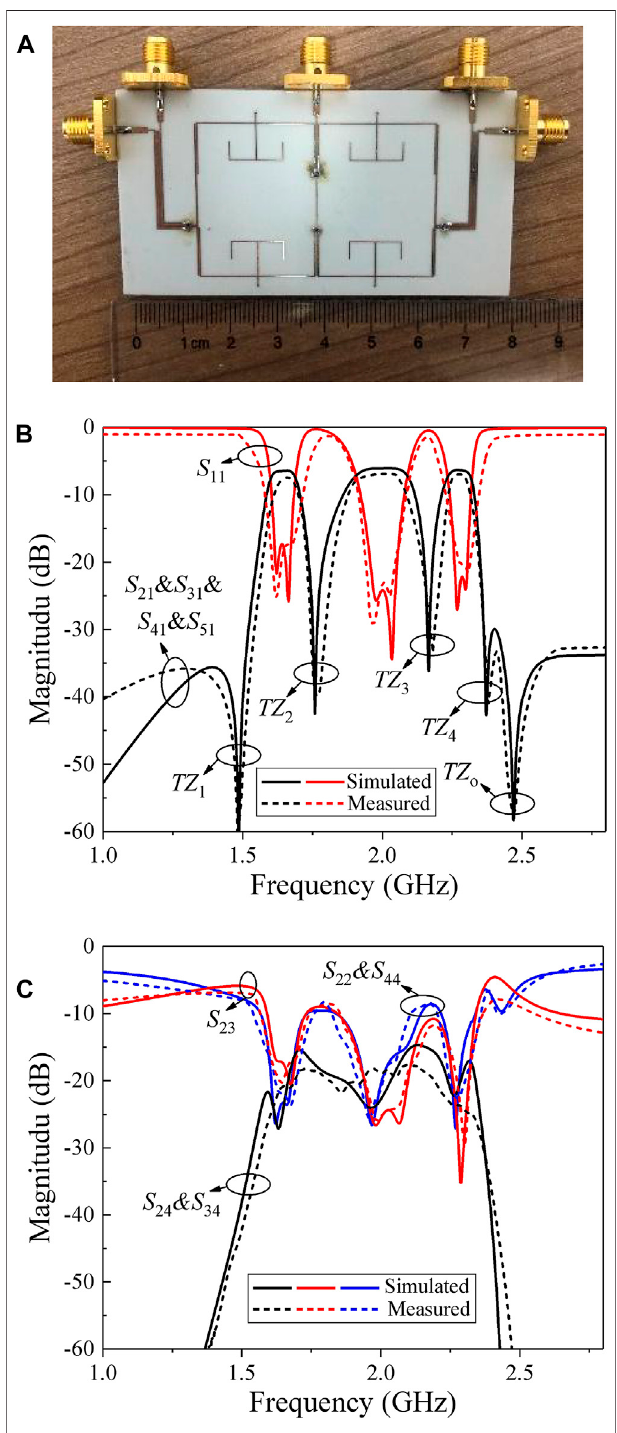
FIGURE 5 | Measured and Simulated results of the four way triple-band FPD. (A) The photograph of the fabricated FPD. (B) Magnitudes of S 11 & S 21 & S 31 & S 41 & S 51 . (C) Magnitudes of S 22 & S 44 & S 23 & S 24 & S 34